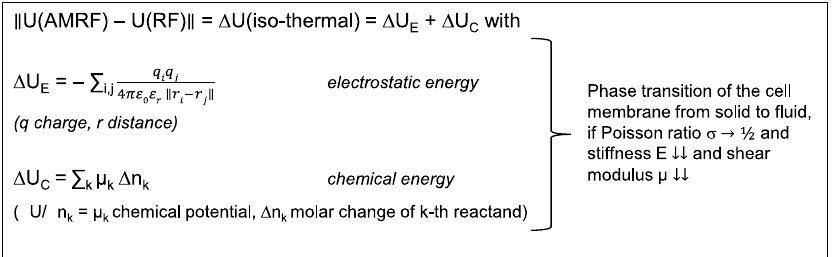
Figure 2. Isothermal energy. Isothermal contributions to the internal energy of tumor cells. These energy depositions do not cause a temperature increase, especially during the heat-up phase. In particular, phase transitions substantially consume isothermal energy. Such phase transitions might occur at the cell membrane under certain